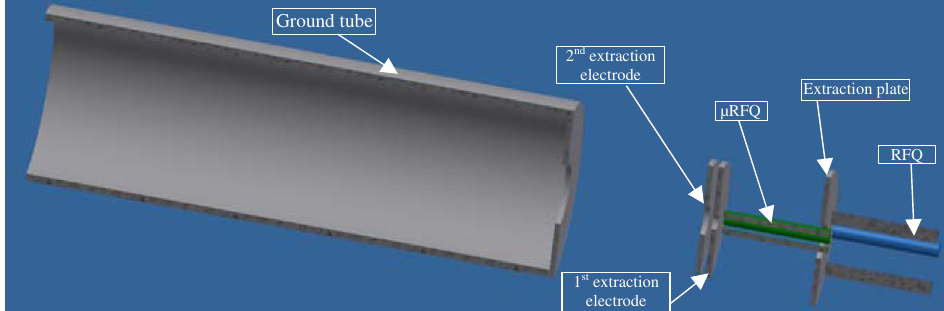
FIG. 5. Layout of the developed extraction section and relative positioning of the μ RFQ from the main RFQ.